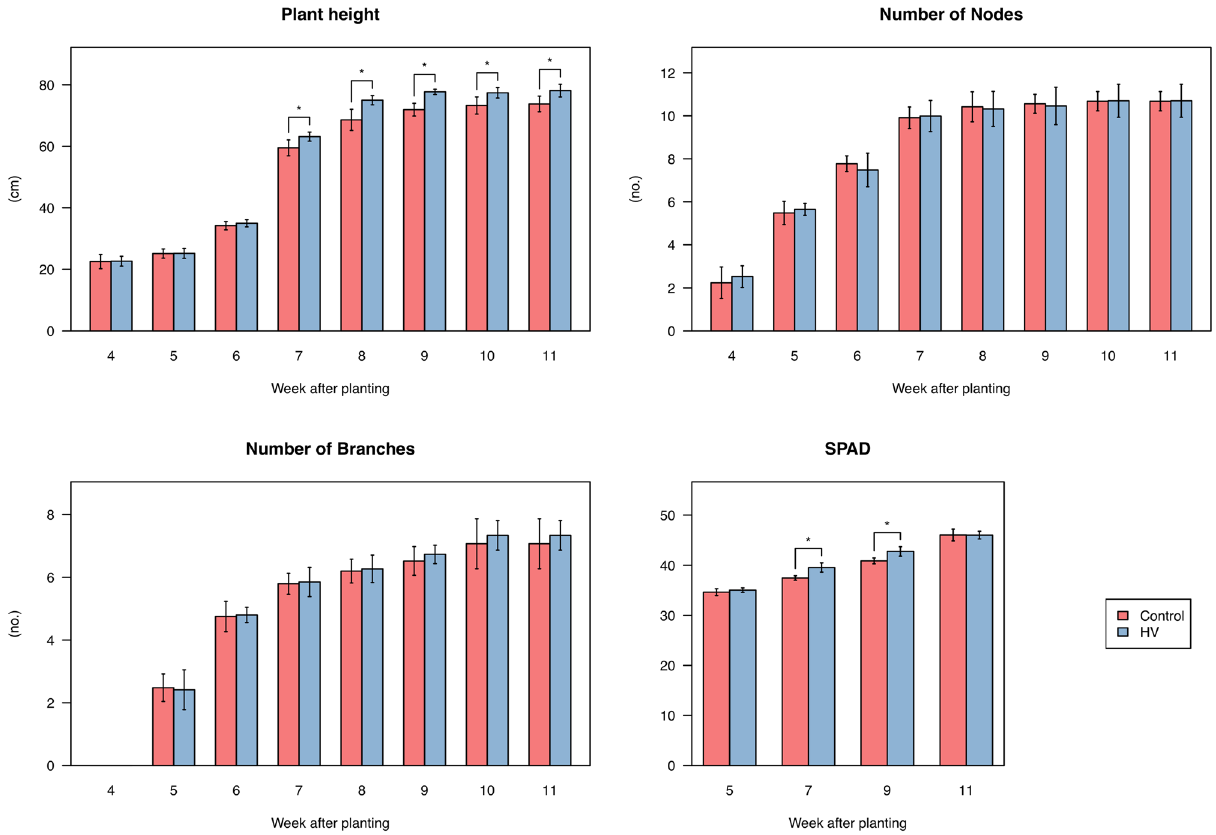
Figure 1. Growth indexes of soybean plants. Values are expressed as means ± SD (n = 5). Asterisks (*) show significant differences between the control plots and HV plots ( p < 0.05, t -test). HV, hairy vetch; SPAD, soil plant analysis